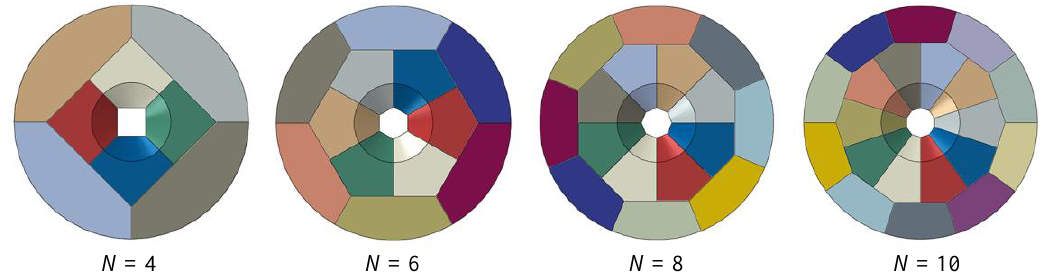
Figure 8. Configurations of the split layer in DLSD with 4, 6, 8 and 10 split blocks.